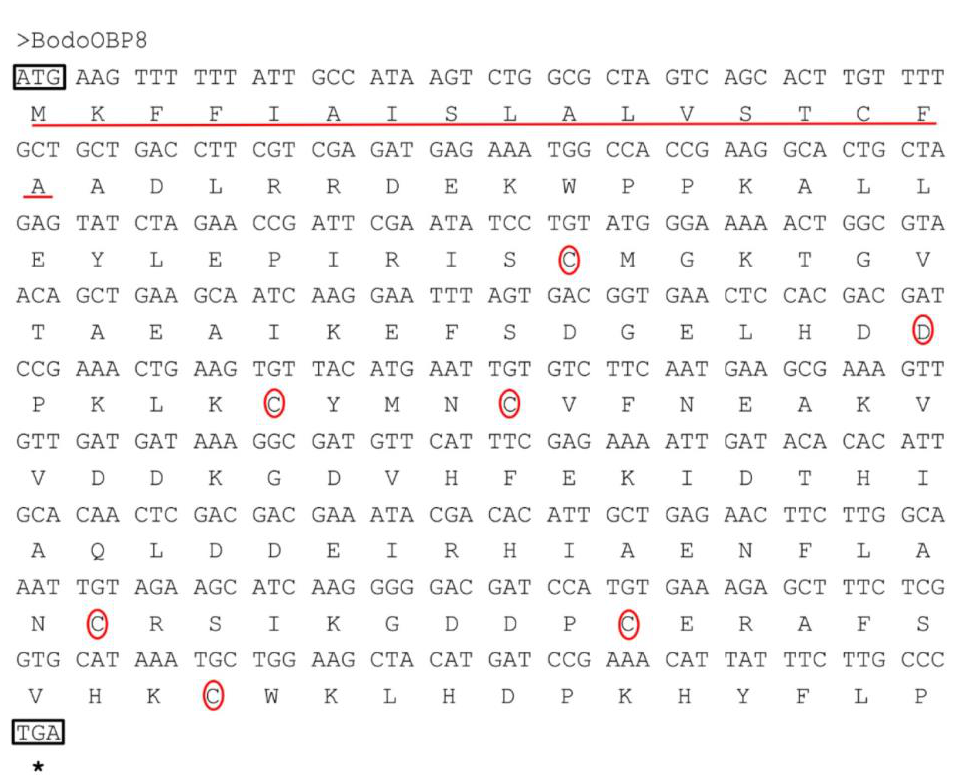
Figure 2. Nucleotide sequences and deduced amino acid sequences of B. odoriphaga OBP8. The predicted signal peptides at the N-terminus are underlined; the six conserved cysteines are marked by red boxes; the initiation and termination condons are indicated in black boxes; the temination codon is represented by an asterisk.